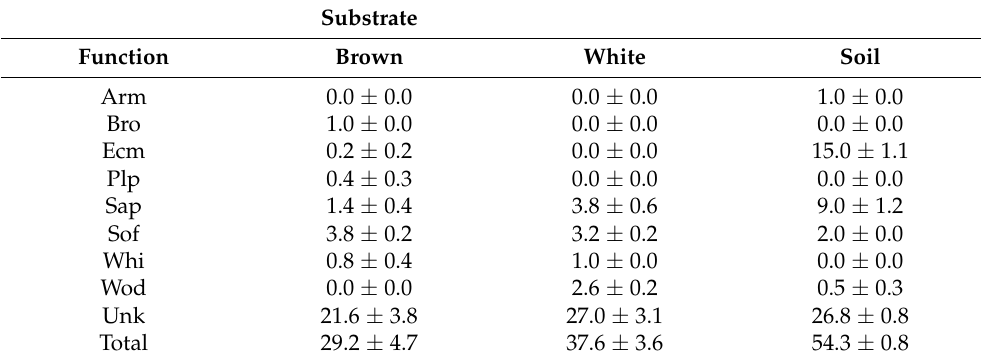
Table 1. OTU richness of fungal functional groups in brown rot wood, white rot wood, and soil. Substrate